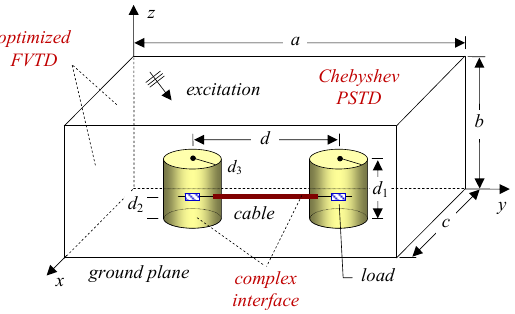
Figure 24: A thin shielded cable. Modeling regions: com- plex-interface schemes for the cylinders and the cable, opti- mized FVTD technique for the cylinders’ interior and the PML, and PSTD algorithm for the rest of the domain.